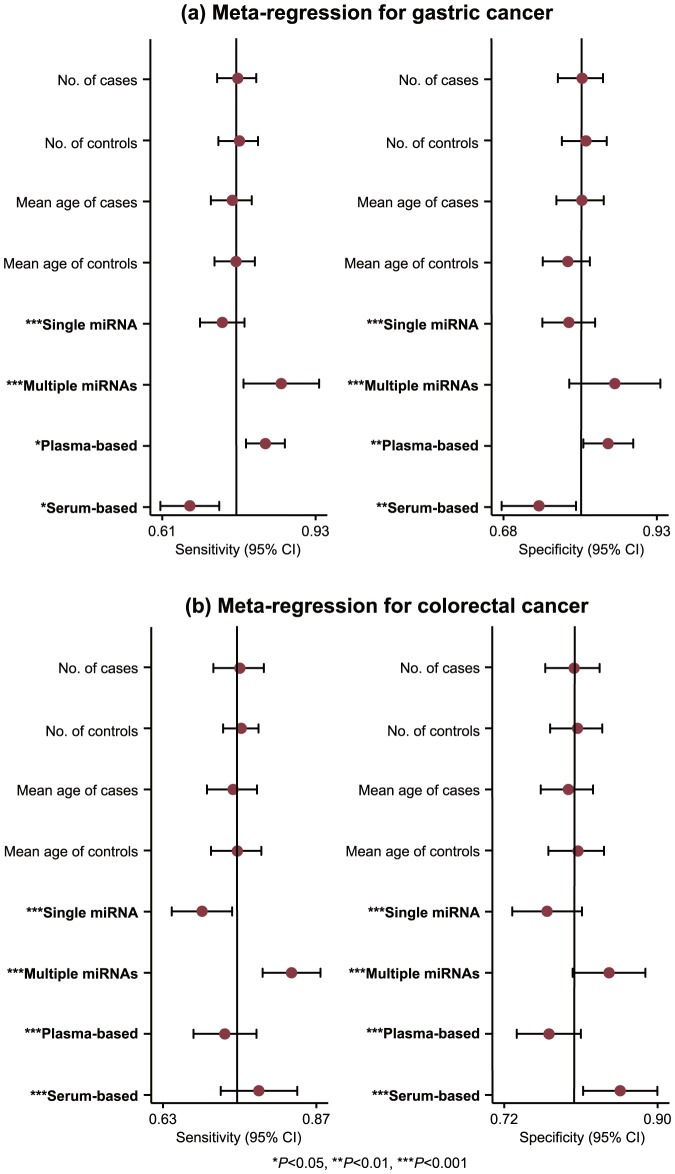
Forest plots of multivariable meta-regression analyses for sensitivity and specificity (a: single-miRNA assay; b: multiple-miRNAs assay).